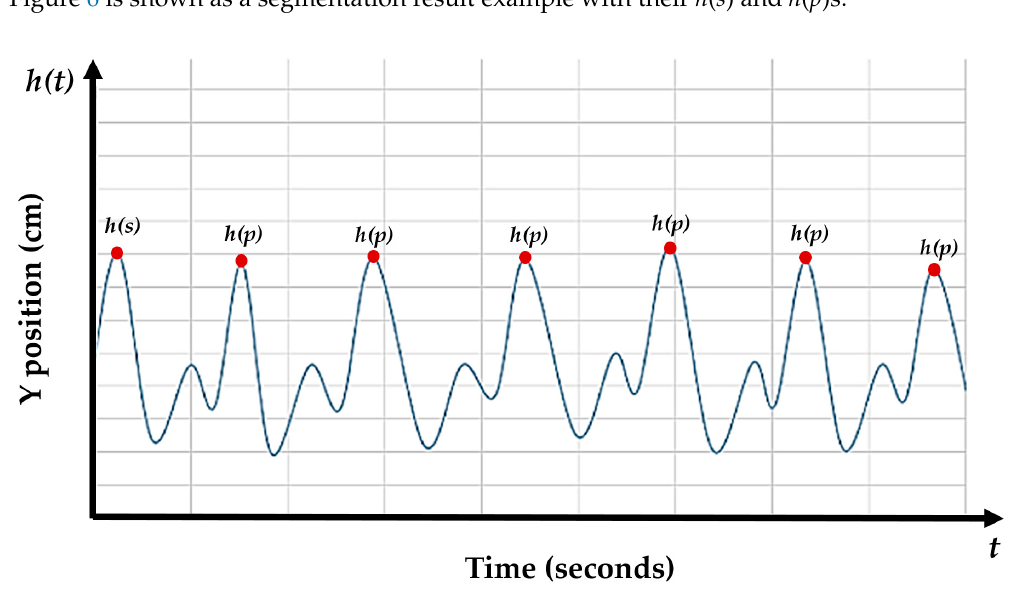
Figure 6. Visualization of a simplified graph of the palm position during a duple gesture after